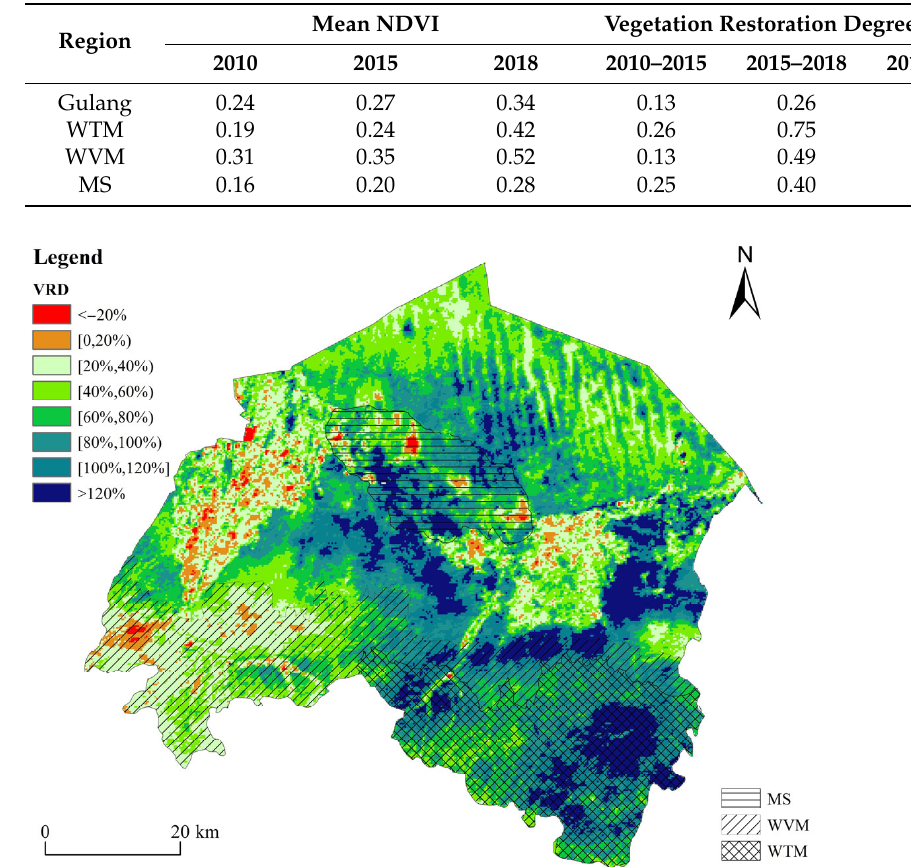
Figure 8. Distribution of vegetation restoration degree.